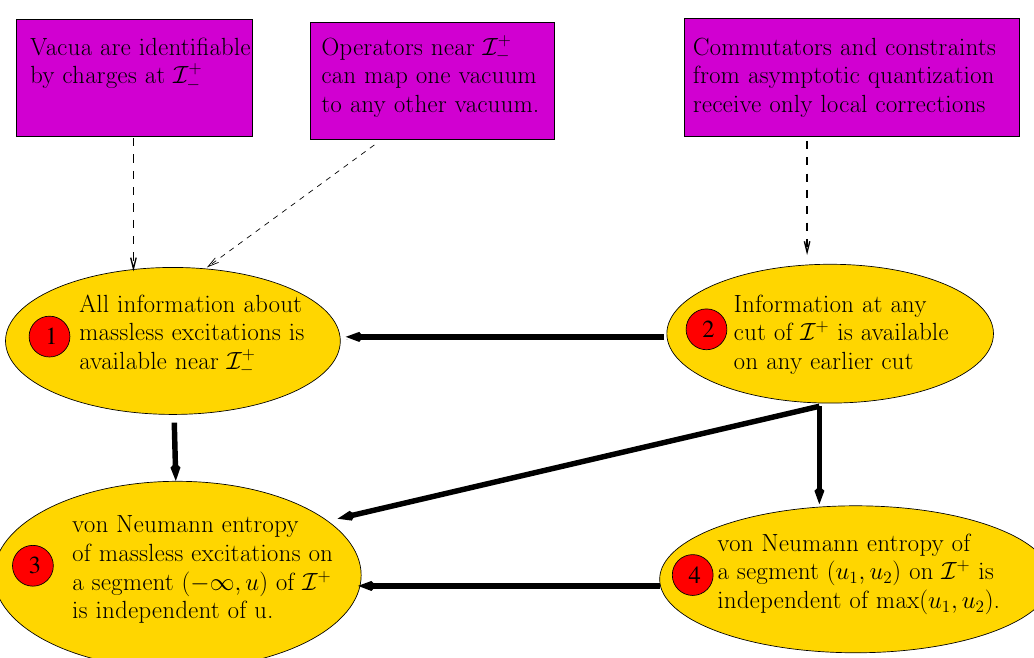
Figure 1: The main results of our paper are displayed in yellow ovals, with numbers in adjoining circles. The purple rectangles indicate physical assumptions. Dependence of a result on an assumption is indicated by a dashed line. Implications between results are denoted by thick black